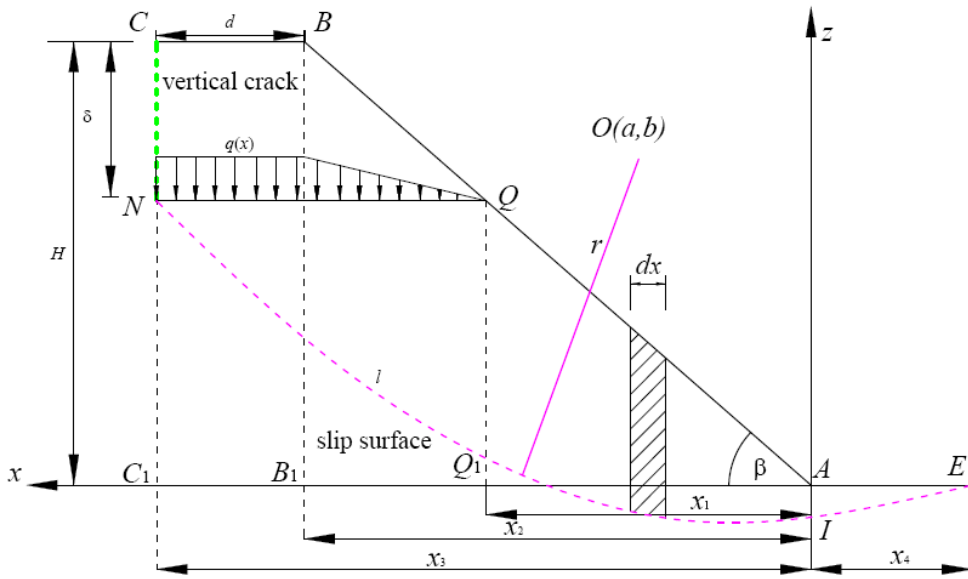
Figure 5. Base circle slope calculated model.